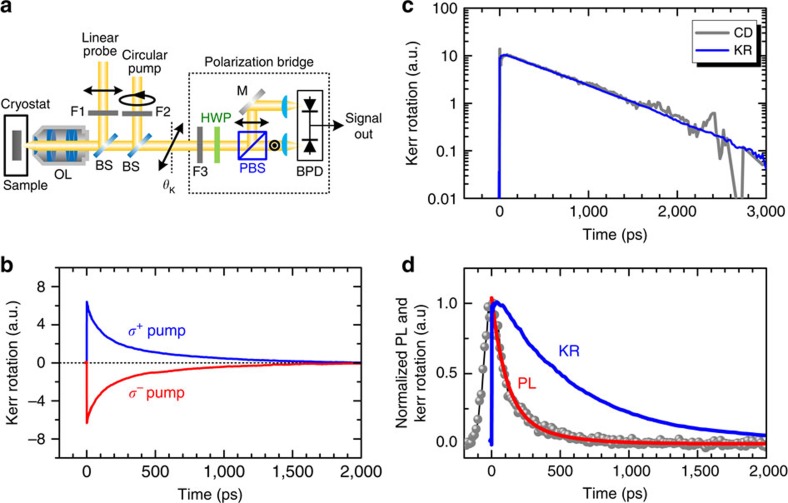
Time-resolved Kerr rotation (TRKR) measurements.(a) Schematic of the experimental set-up for TRKR spectroscopy. The circularly polarized pump pulses and the linearly polarized probe pulses with a time delay were focused through an objective lens (OL) and at normal incidence to the sample surface. The wavelengths of the pump and the probe pulses were selected individually by two edge-pass filters F1 and F2. The Kerr rotation (θK) of the reflected probe pulses was analysed by a polarization bridge consisting of a half waveplate (HWP), a polarization beamsplitter (PBS) and a pair of balanced photodiodes (BPD). Before entering the polarization bridge, the pump beam was filtered out by a long-pass filter F3. BS stands for beamsplitter and M stands for mirror. (b) TRKR traces probed at 1.719 eV under σ+ (blue) and σ− (red) pumping. The Kerr rotation signal changes sign when reversing the pump pulse helicity. (c) A comparison between the measured Kerr rotation (KR, blue curve) and circular dichroism (CD, grey curve) obtained from helicity-resolved transient reflection using the same experimental conditions. Both KR and CD show the same decay dynamics. (d) Temporal evolutions of PL intensity (grey symbols) and KR (blue curve). The red curve is a single-exponential fit to the PL decay.